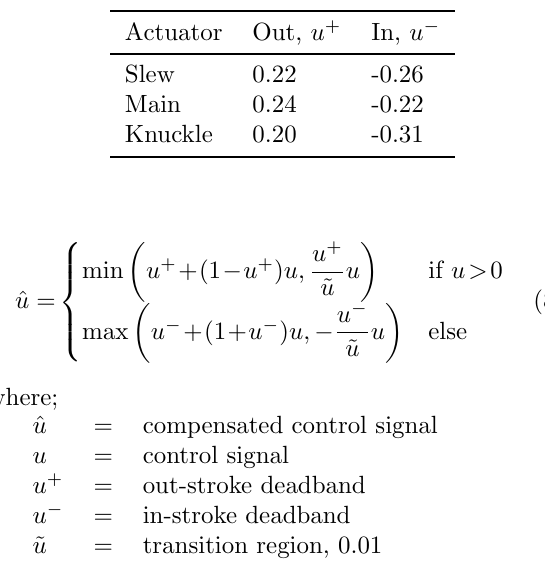
Table 6: Identified deadband for the actuators.